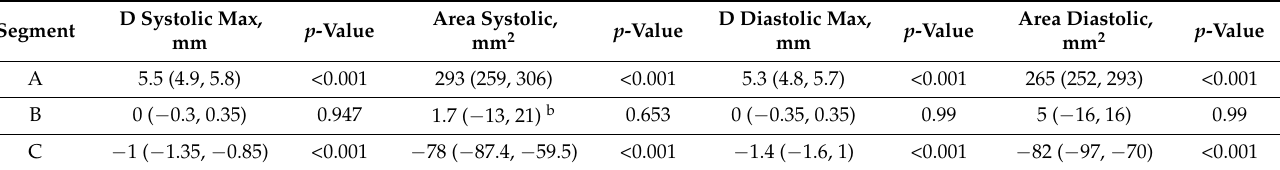
Table 5. Segmental shapes of ascending aorta during the heart cycle a .